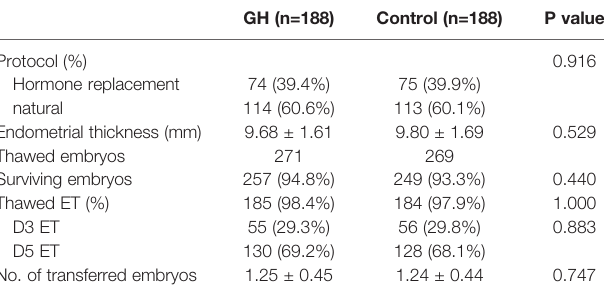
TABLE 3 | Characteristics of frozen-thawed cycle treatment.